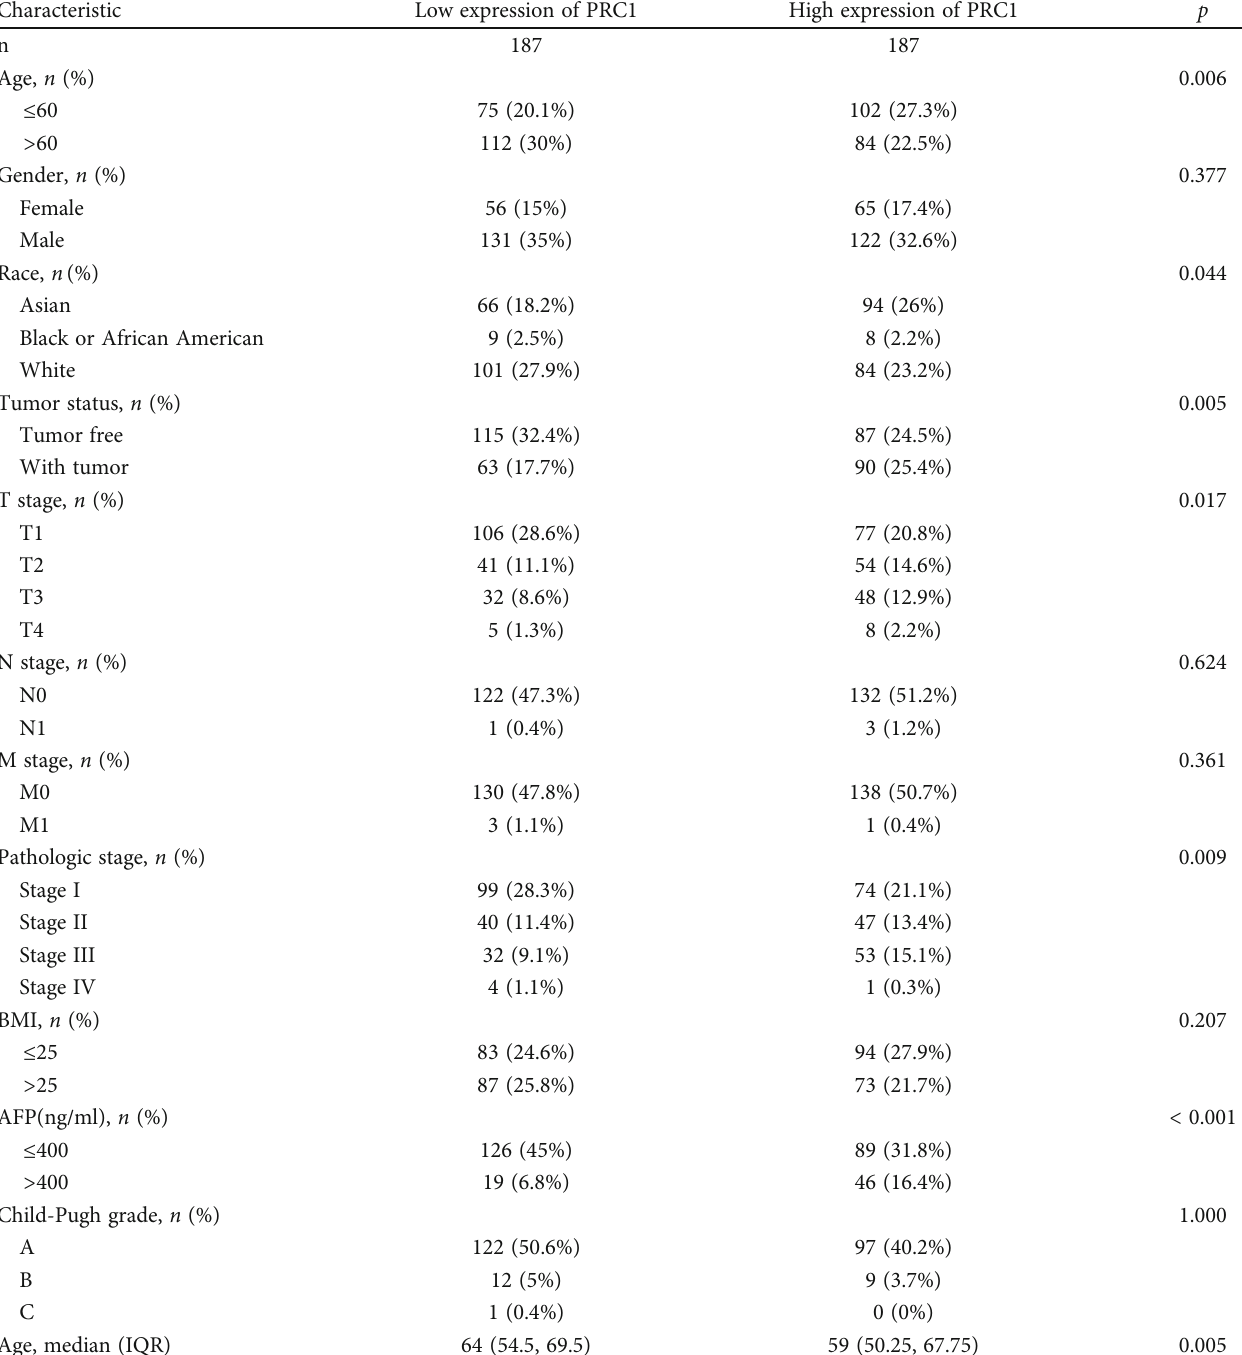
Table 1: The baseline characteristics of the LIHC patients from the TCGA